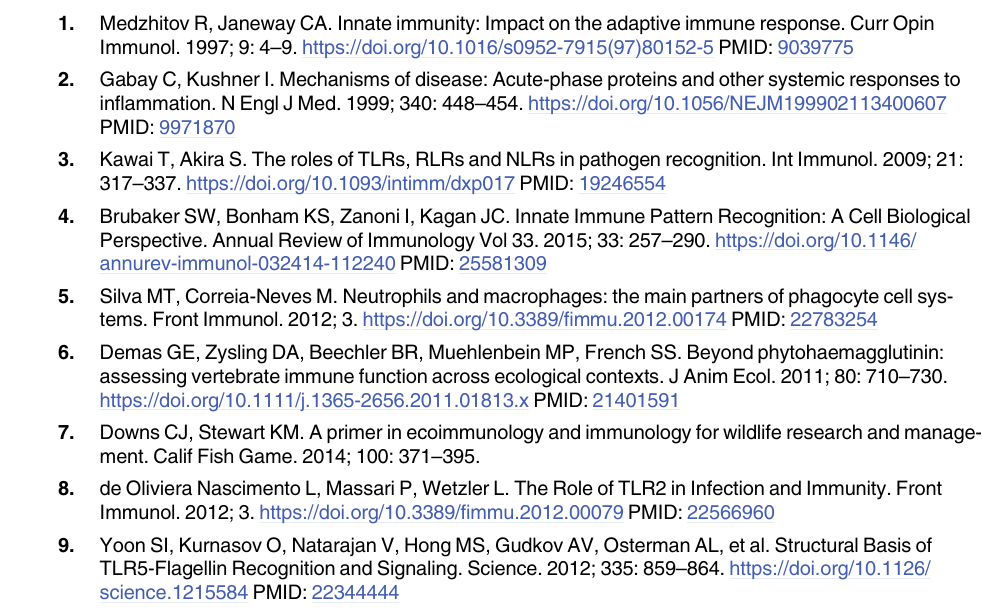
S1 Table. Primer sets for TLR quantitative PCR of seven ungulates at Wildlife Safari. S2 Table. Wildlife Safari study individuals. These ungulates were sampled 2013–2014. Health status indicates minor health problems of some animals included in the